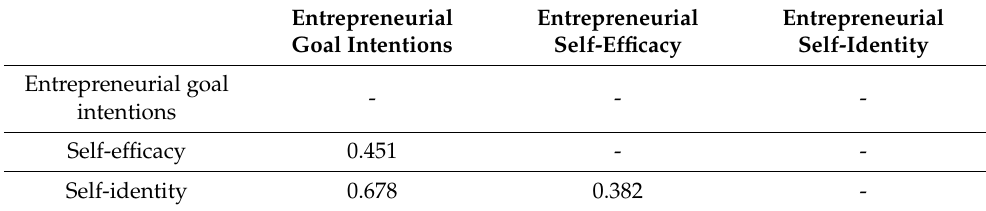
Table 2. Discriminant validity (HTMT) criterion.